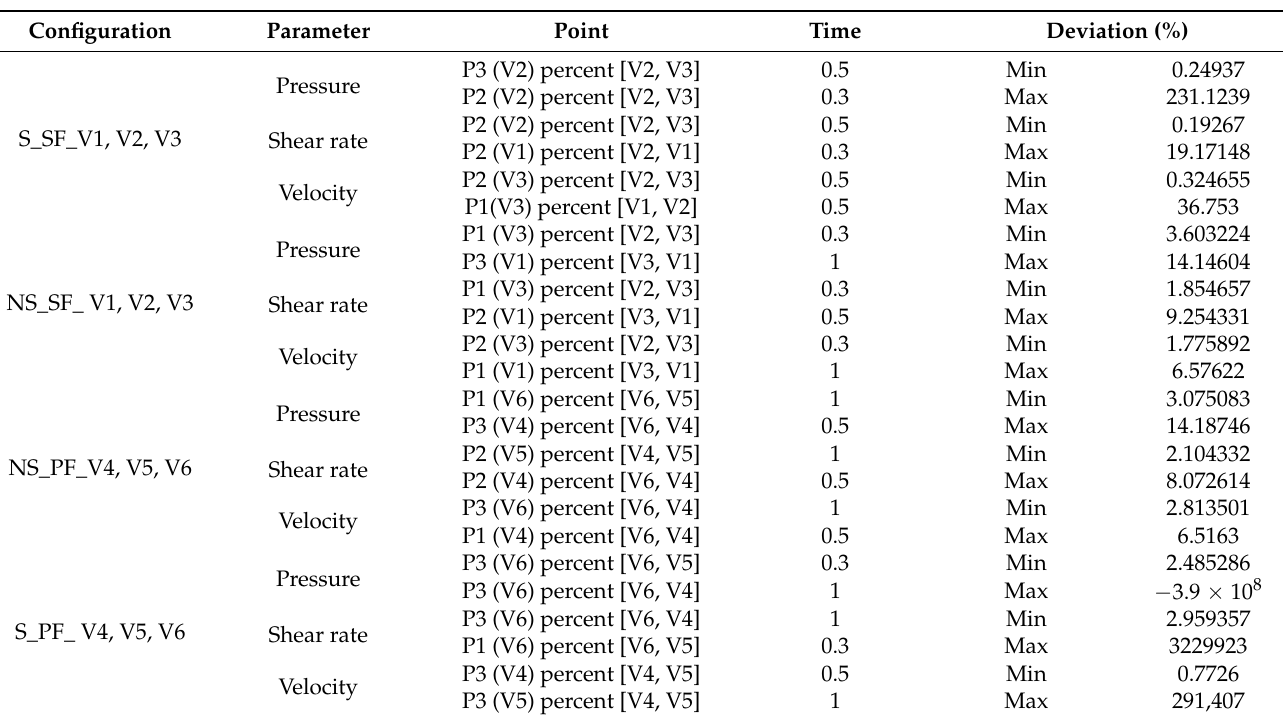
Table 7. Calculated deviation for pressure, shear rate and